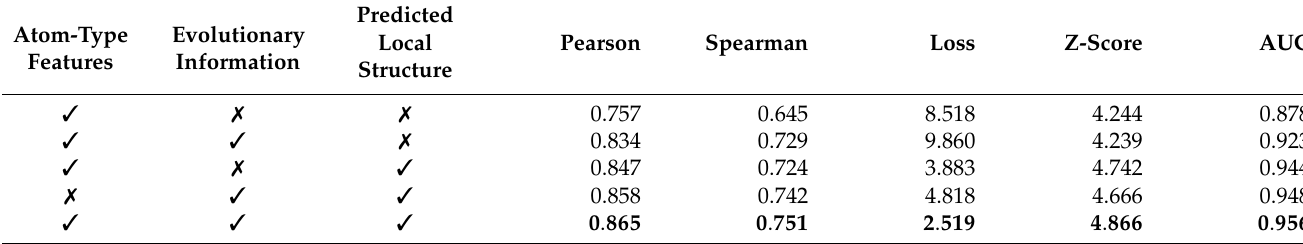
Table A3. Performance comparison in the validation dataset by feature